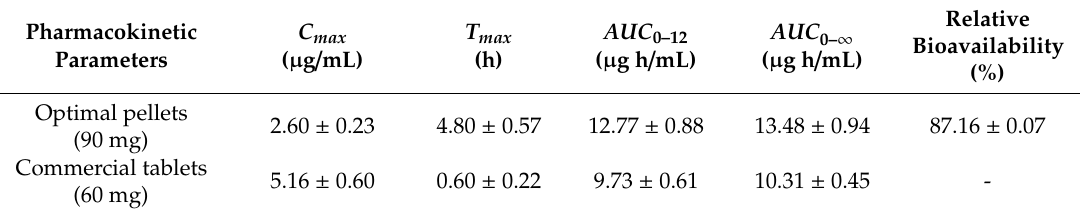
Figure 9. Plasma drug concentrations vs. time after oral administration of conventional tablets (60 mg) and sustained release pellets (90 mg). Table 6. The pharmacokinetic parameters of loxoprofen after oral administration of the optimal sustained release pellets and commercial tablets in beagle dogs ( n = 6).